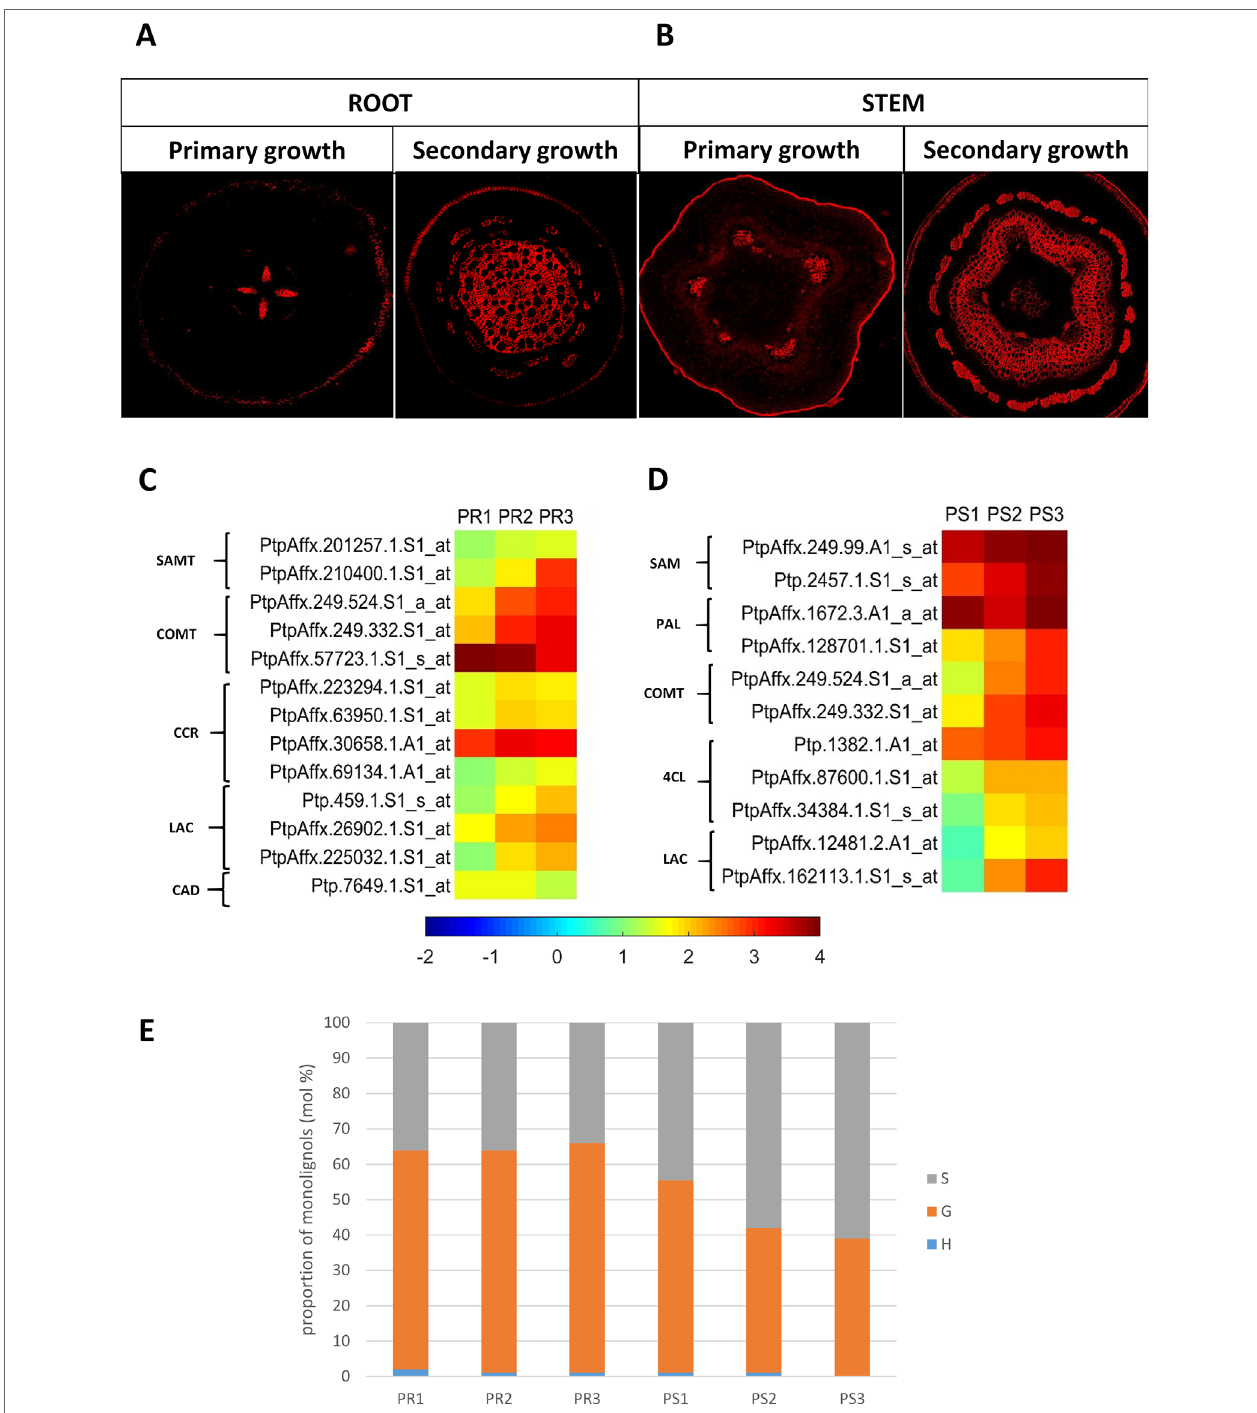
FIGURe 4 | (a) Autofluorescence of lignins in pioneer roots and (B) stem of Populus trichocarpa . (C) Expression profile of genes related to lignin metabolism in pioneer roots and (D) stem of black cottonwood. SAMT, S-adenosyl-L-methionine:carboxyl methyltransferase; COMT, caffeic acid O-methyltransferase; CCR, cinnamoyl-CoA reductase; LAC, laccase; CAD, cinnamyl alcohol dehydrogenase; SAM, S-adenosylmethionine synthetase; PAL, phenylalanine ammonia- lyase; 4CL, 4-coumarate:CoA ligase. (e) Cell wall lignin composition in pioneer roots and stem of P. trichocarpa . Cell wall lignin composition was measured from alcohol-insoluble residues extracted from stem and root tissues. H (p-hydroxyphenyl), G (guaiacyl), S (syringyl) lignin monolignols.